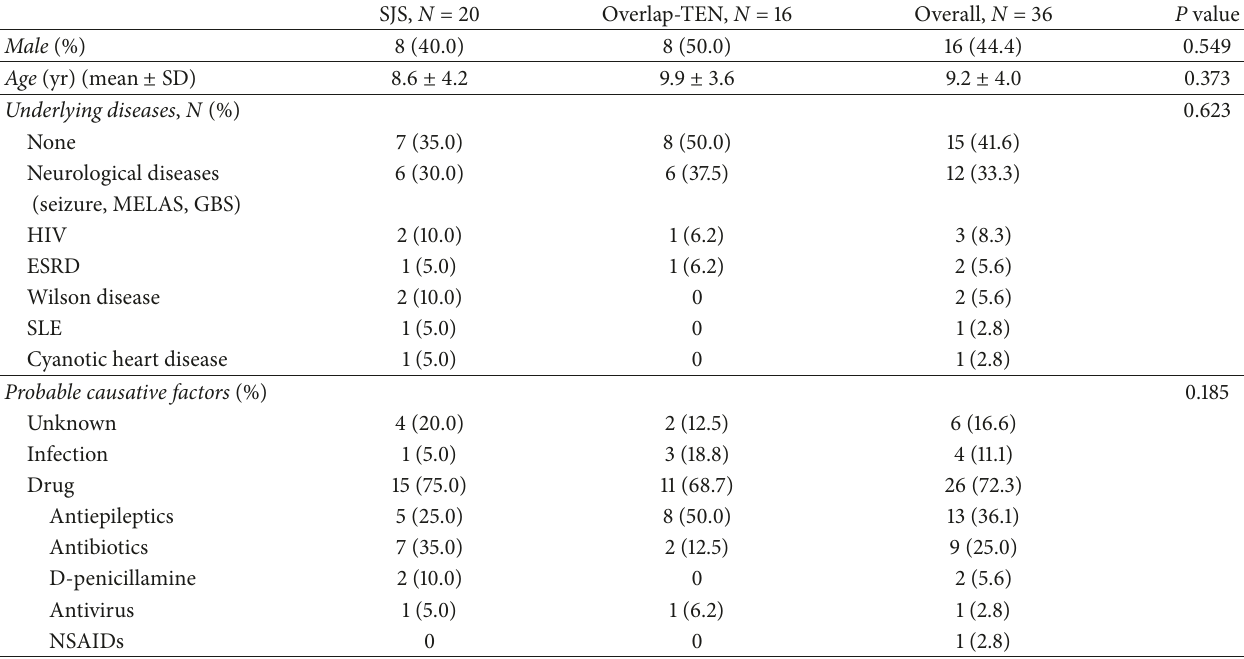
Table 1: Demographics of patients with Stevens-Johnson syndrome and overlap-toxic epidermal necrolysis.